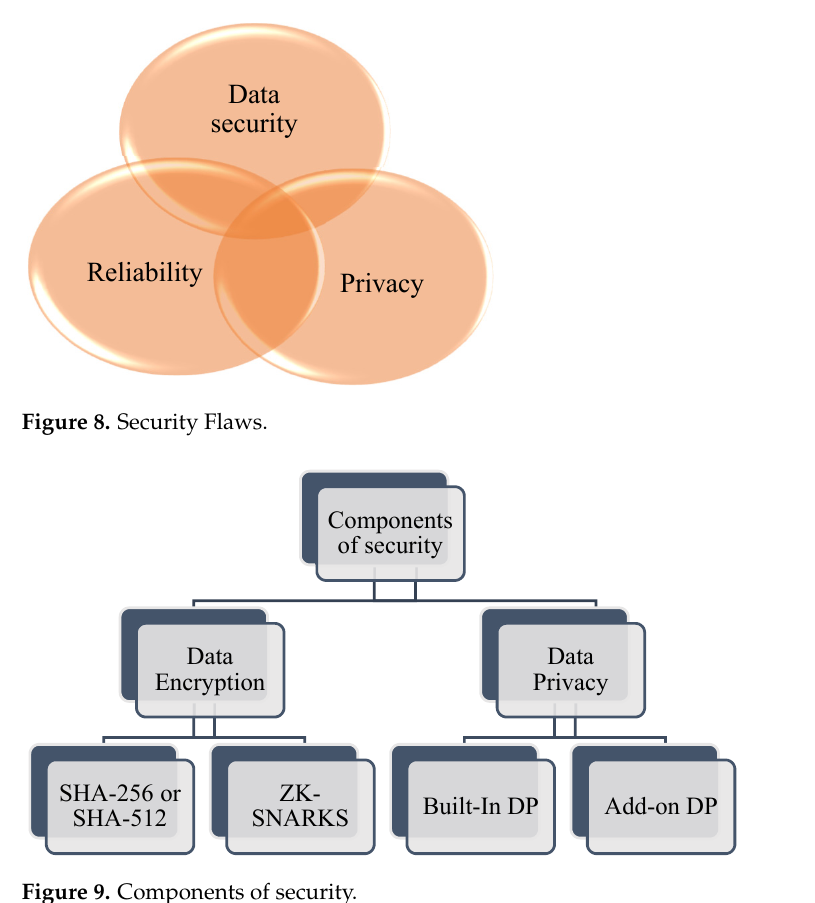
Figure 9. Components of security.